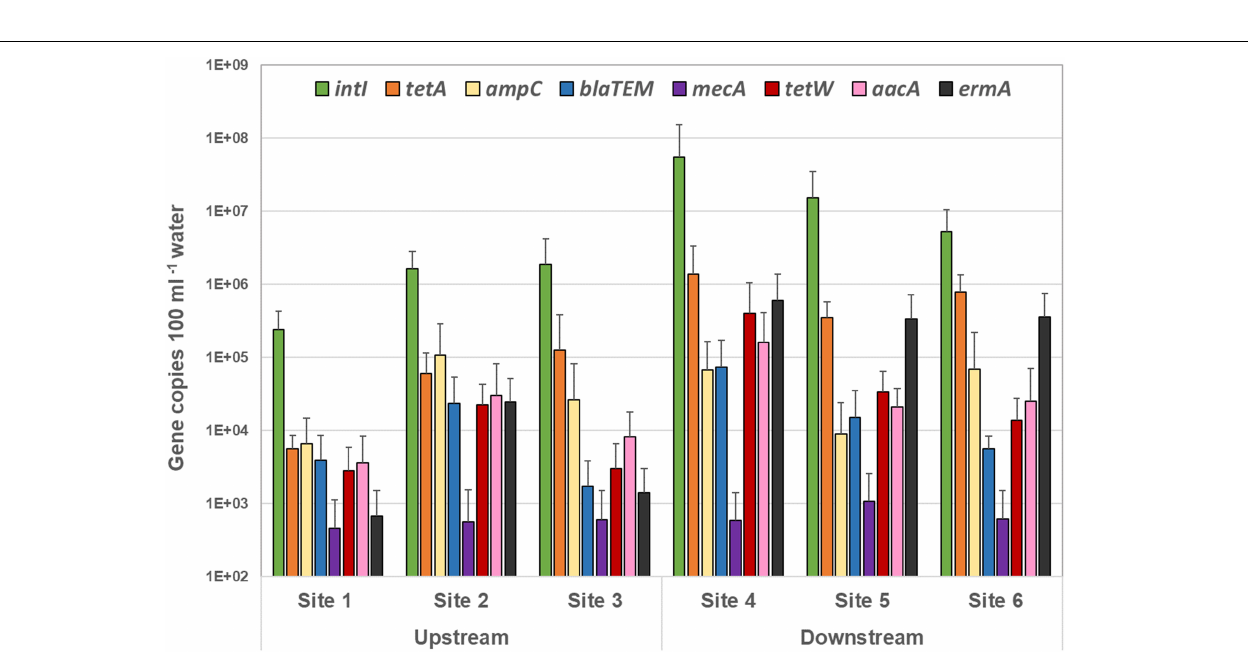
FIGURE 4 | Concentrations (log 10 CFU/mL) of (A) HPC-Am, (B) HPC-Tet and (C) HPC-Su across sampling sites for all sampling events.